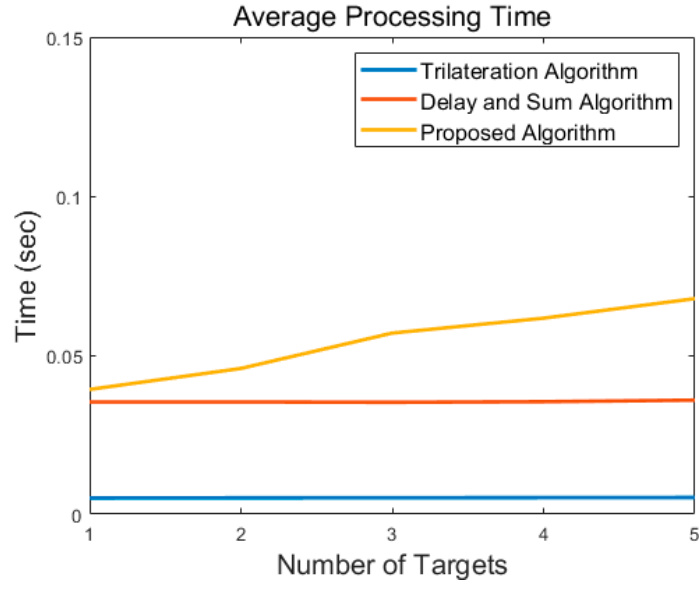
Figure 19. Comparison of processing time according to number of targets.